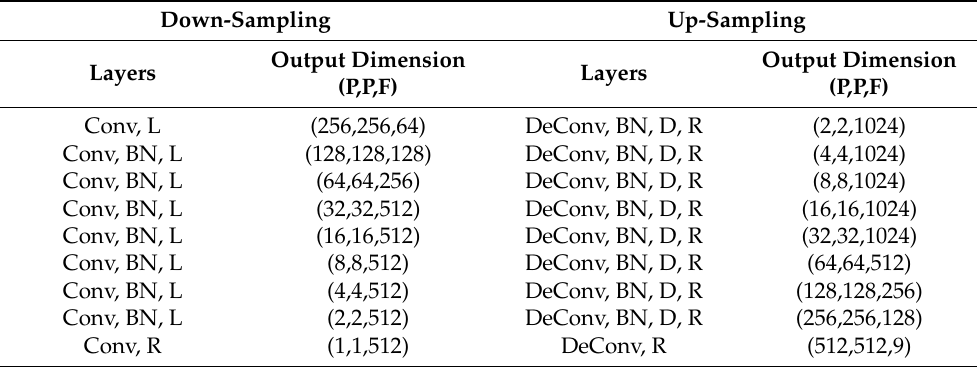
Table 3. List of the structures and hyperparameters of the U-Net-based generator (P: patch size; F: number of features; Conv: convolution; BN: batch normalization; L: leaky ReLU; Deconv: transposed convolution and cropping; D: dropout; R: ReLU).